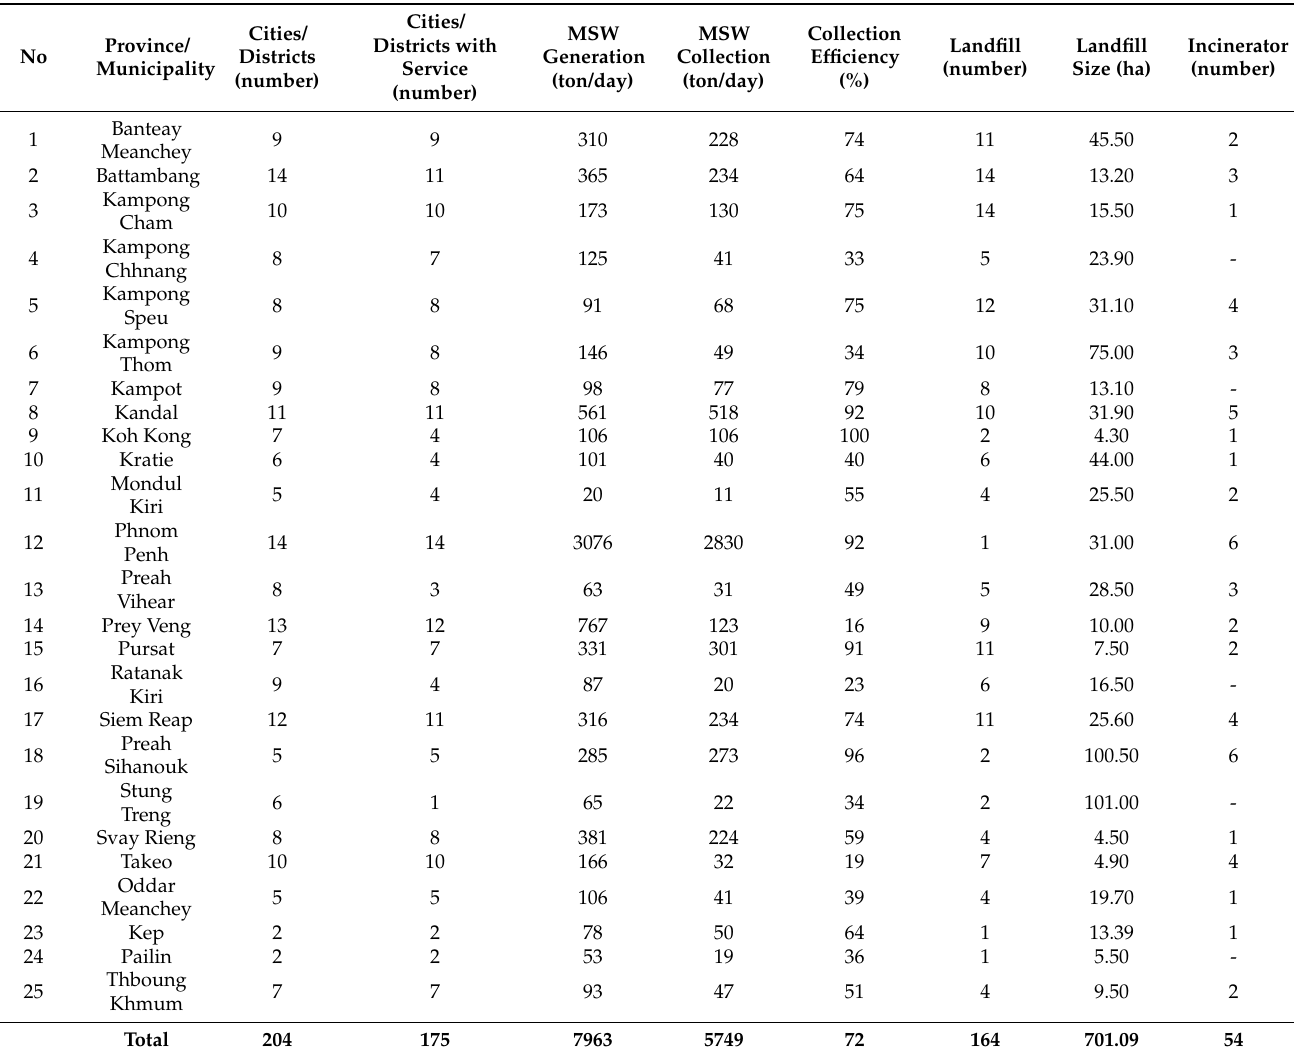
Table 3. Waste collection in the city and district centers of Cambodia in